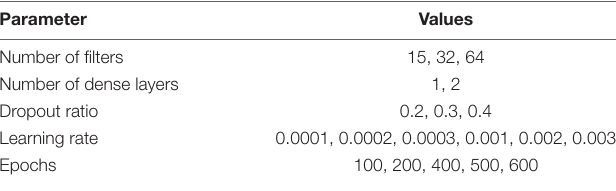
TABLE 4 | Explored hyperparameter values for the CNN-1D